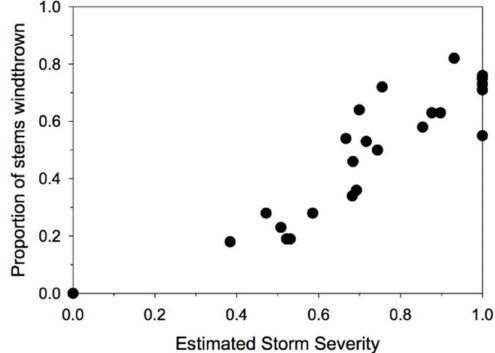
Figure 2. The relationship between the estimated storm severities for the 24 plots in the study and the observed proportion of stems >10 cm DBH that were windthrown. Note that the actual proportions of stems windthrown is a function of both storm severity and differences among plots in species composition and size structure, as well as logging history.